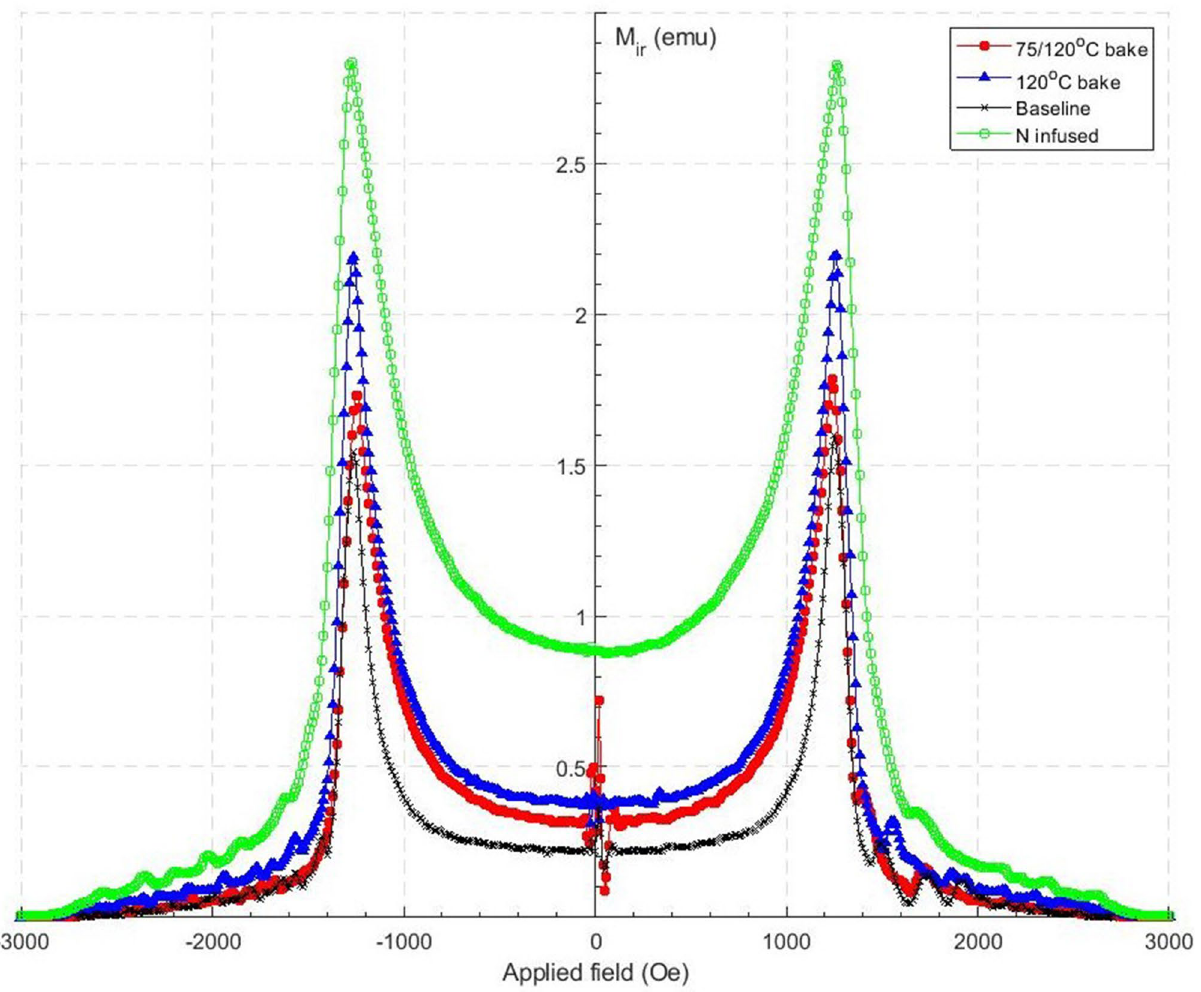
Figure 2. The irreversible pinning (M ir ) for each treatment at 4.2